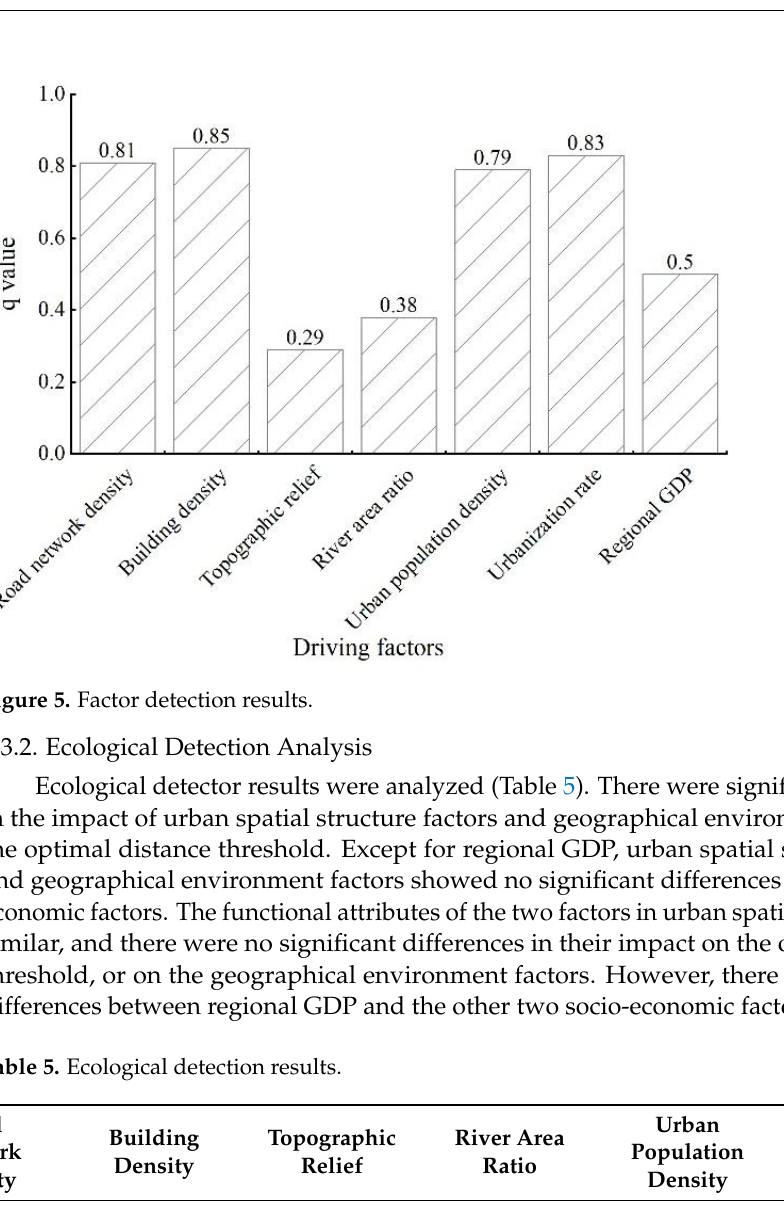
Table 5. Ecological detection results.